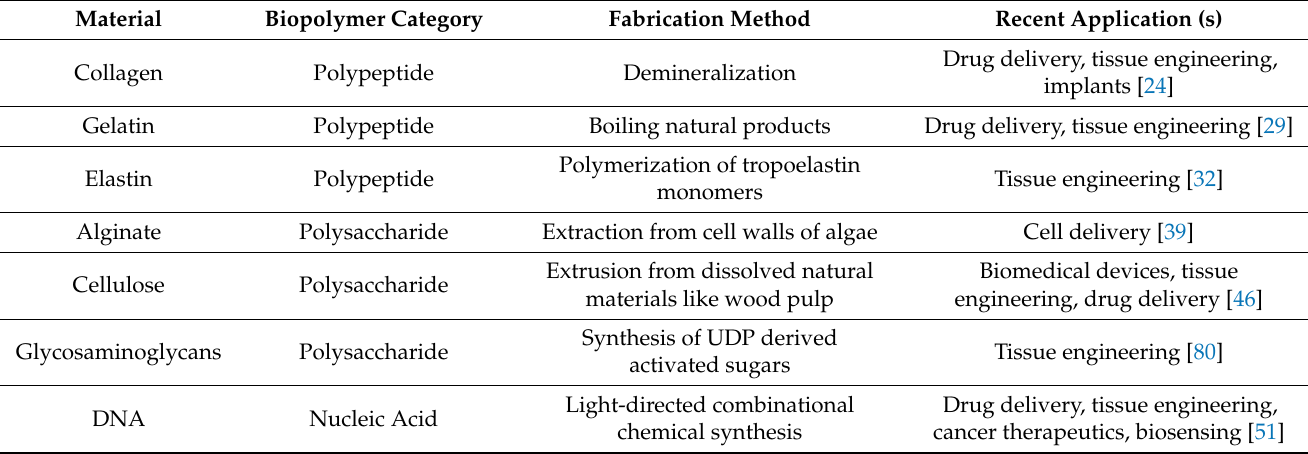
Table 2. Overview of biopolymer materials used in hydrogel